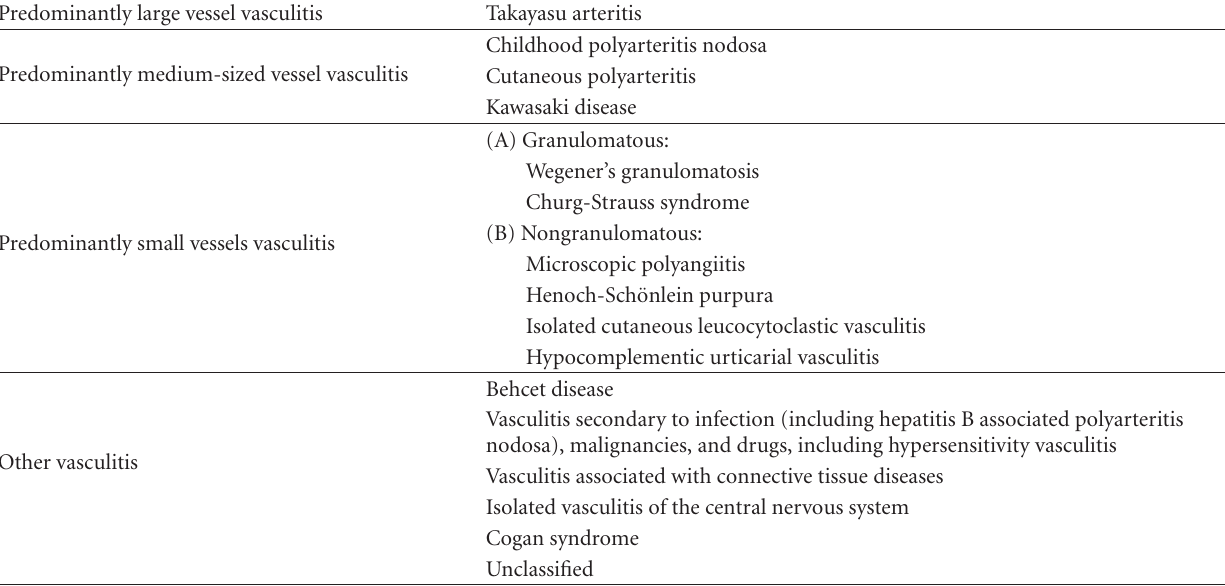
Table 2: New classification of childhood vasculitis